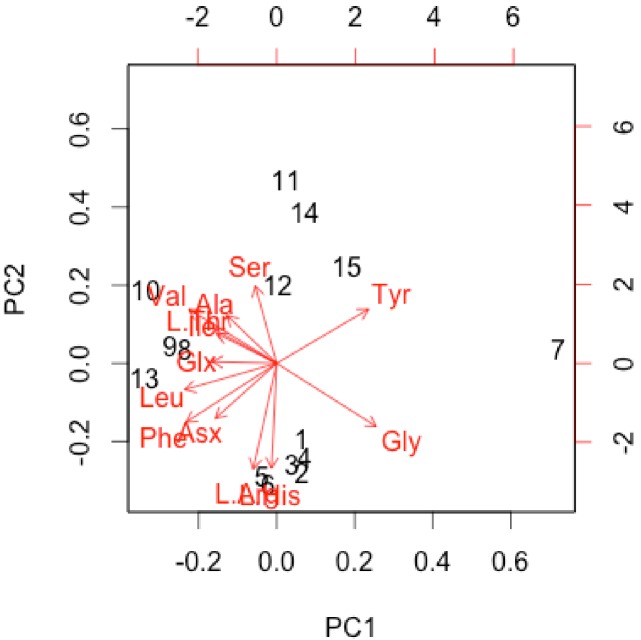
Normalised PCA biplot of THAA composition of only the sufficiently treated samples associated with Appendix 1—figure 22.